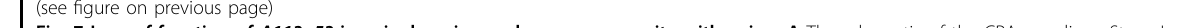
Fig. 7 Loss-of-function of Δ 113p53 impairs learning and memory capacity with aging. A The schematic of the CPA paradigm. Stage I: Adaptation period in the tank covered with white color (5 min/day for 3 days); Stage II: Baseline period in the test tank covered by one side with red color and the other with white color (5 min/day for 6 days without electric shock); Stage III: Conditioning period in the test tank (5 min/day for 7 days after electric shock from white color). In stage II, zebra fi sh behavior was recorded for the Baseline period. In stage III, a mild electric shock for one min (twice/day in 1-h interval) was delivered each time the fi sh entered the white zone. Zebra fi sh behavior was recorded 1 day after the treatment for the conditioning period. After recording, the fi sh was treated again and the assay was repeated for 7 days. B – G Statistical analysis of CPA assays on Δ 113p53 + / + and Δ 113p53 M/M zebra fi sh at 5- or 19-months old. The paired t test was applied for the comparison of the time spent in the white color out of 300 s ( = 5 min) recorded between baseline and conditional periods within the same genotype either Δ 113p53 + / + ( B , E ) or Δ 113p53 M/M ( C , F ). Each dot represents the time for individual fi sh spending in the white zone. Two-way ANOVA analysis was performed to analyze the differences of the average time spent in the white color at each time point between two genotypes of Δ 113p53 + / + and Δ 113p53 M/M at 5- ( D ) or 19- ( G ) months old. BL Baseline period. In each group, eight zebra fi sh were used. Within-group comparison: paired t test. Between-group comparison: two-way ANOVA test. The P values were represented by N.S. and asterisks. N.S., P > 0.05, * P < 0.05, ** P <